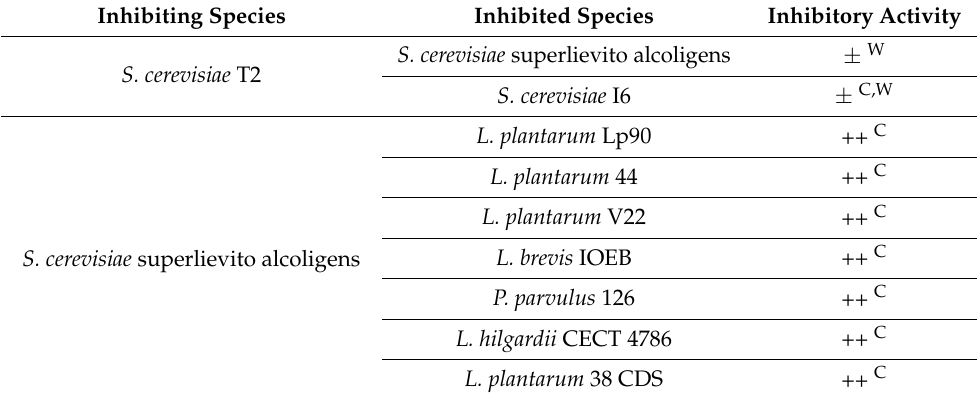
Table 3. Inhibitory activity of S. cerevisiae strains according to the diameter of halo of inhibition: “ ± ” = lower than 3 mm, “+” = ranging from 3–6 mm and “++” = more than 6 mm. Inhibiting Species